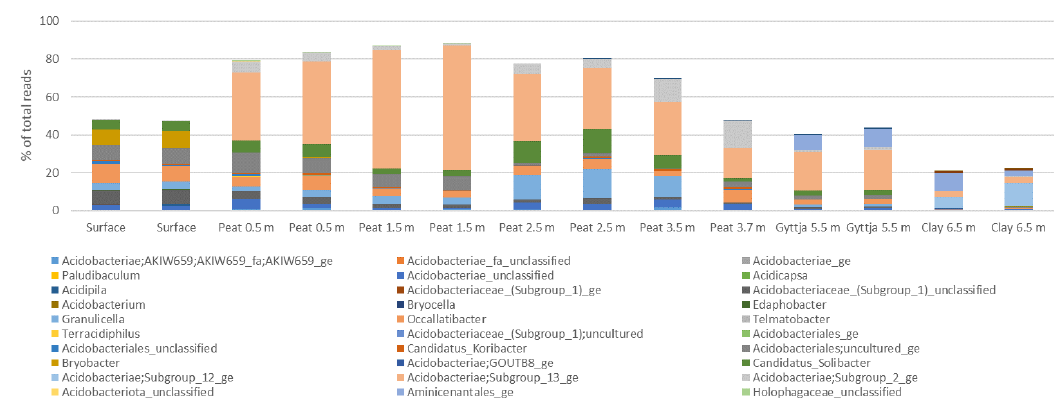
Figure A4. The relative abundance of Acidobacteriotal genera in Lastensuo Bog samples.